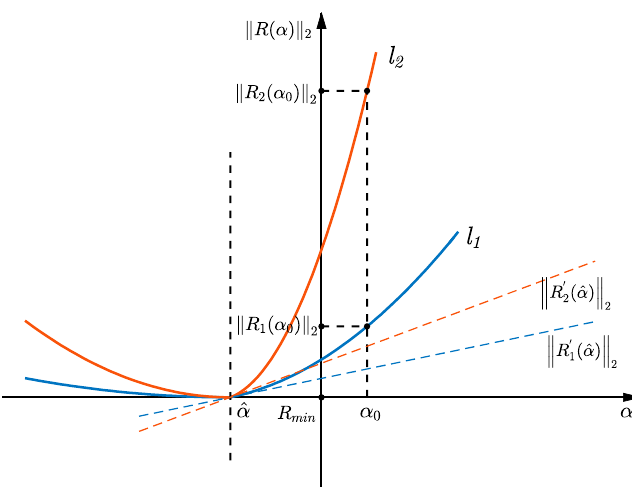
Figure 1. A comparison of two residual sub-functions with different residual-damage sensitivity.